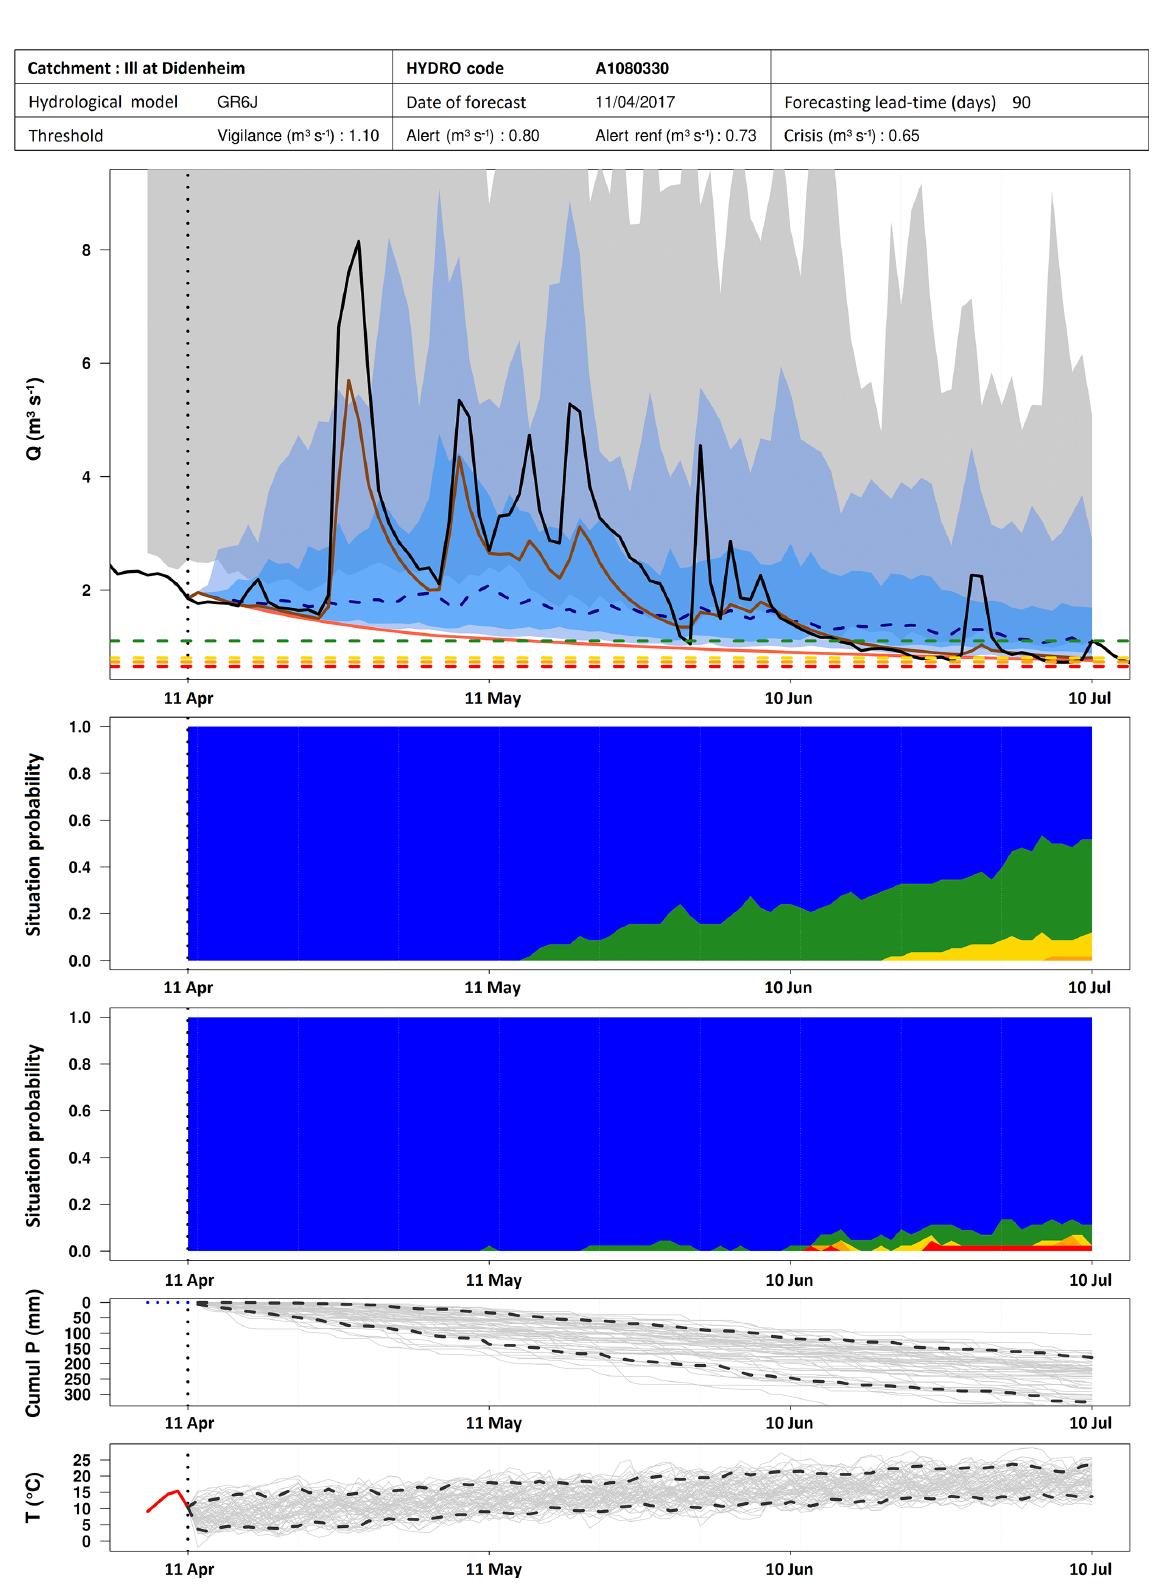
Figure 3. Example of streamflow forecast synthesis plot provided by PREMHYCE on 11 April 2017 for the Ill River at Didenheim with